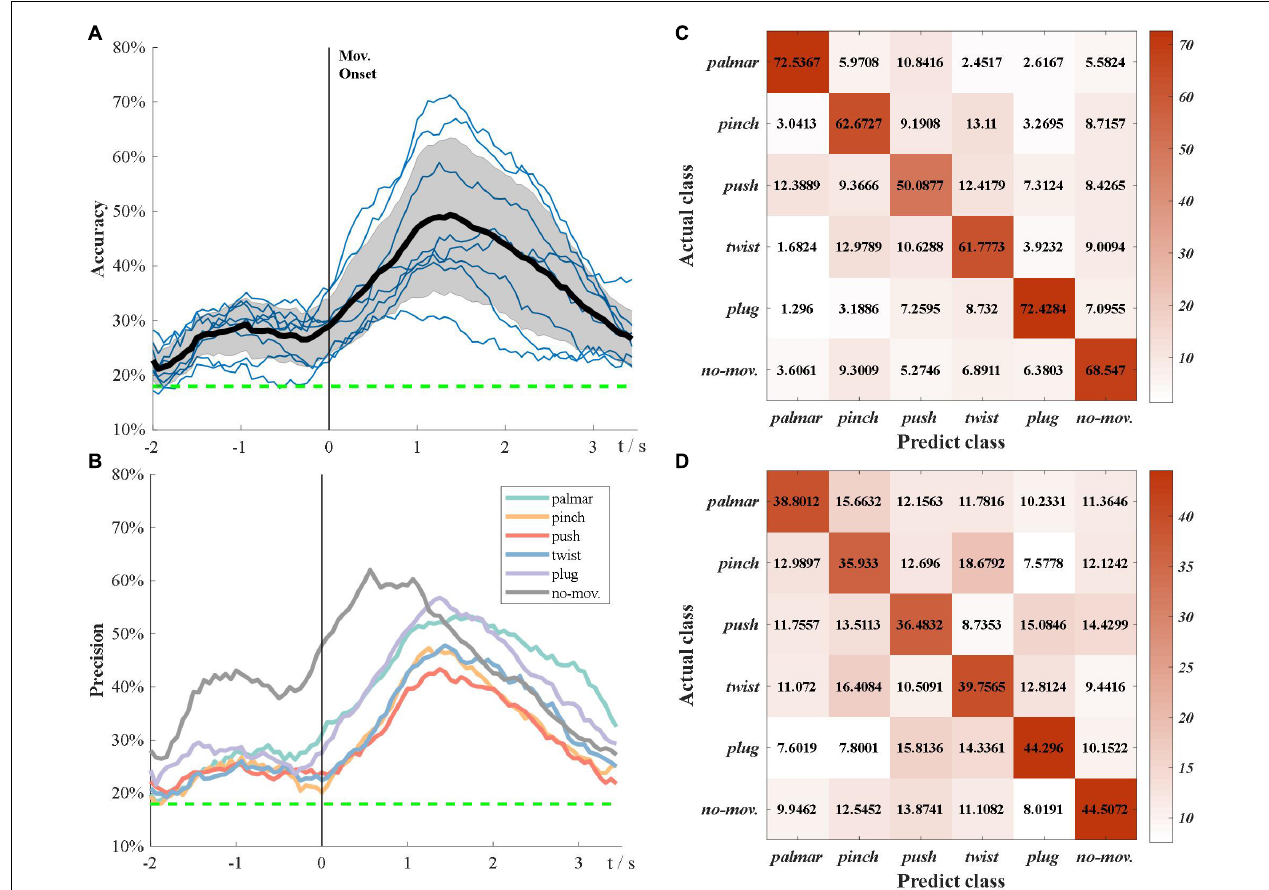
FIGURE 6 | Multiclass classification results. (A) Grand average classification accuracy over tROI. The thin blue line represents subject-specific accuracy; the bold line represents grand average accuracy; the shadow shows the standard deviation of grand average accuracy; the green dotted line represents grand average significance level: 17.75%. (B) Grand average classification precision of each task over tROI. (C) Average confusion matrix of group 1 at grand average peak time. (D) Average confusion matrix of group 2 at grand average peak time.